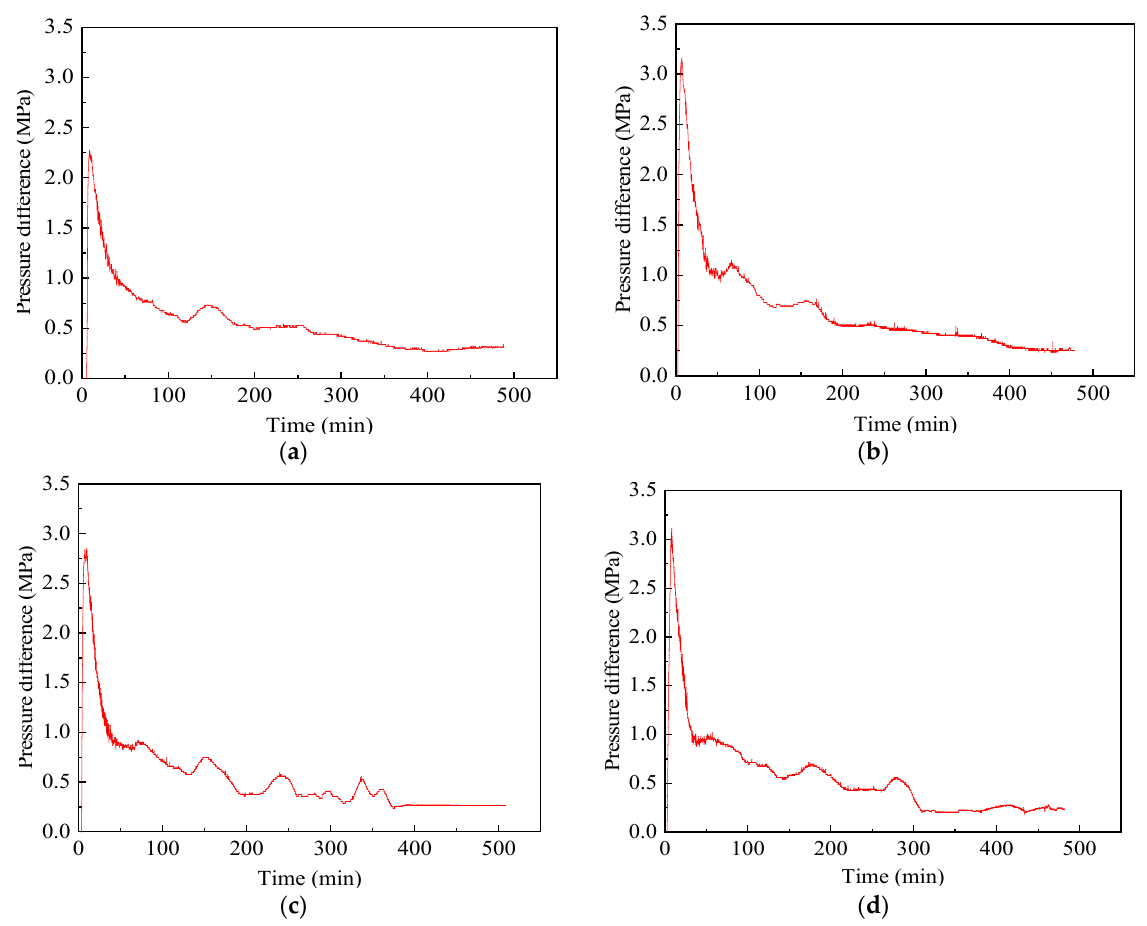
Figure 6. Variation in the displacement pressure difference under different displacement modes: ( a ) pure steam flooding, ( b ) N 2 + steam flooding, ( c ) CO 2 + steam flooding, and ( d ) flue gas + steam flooding.